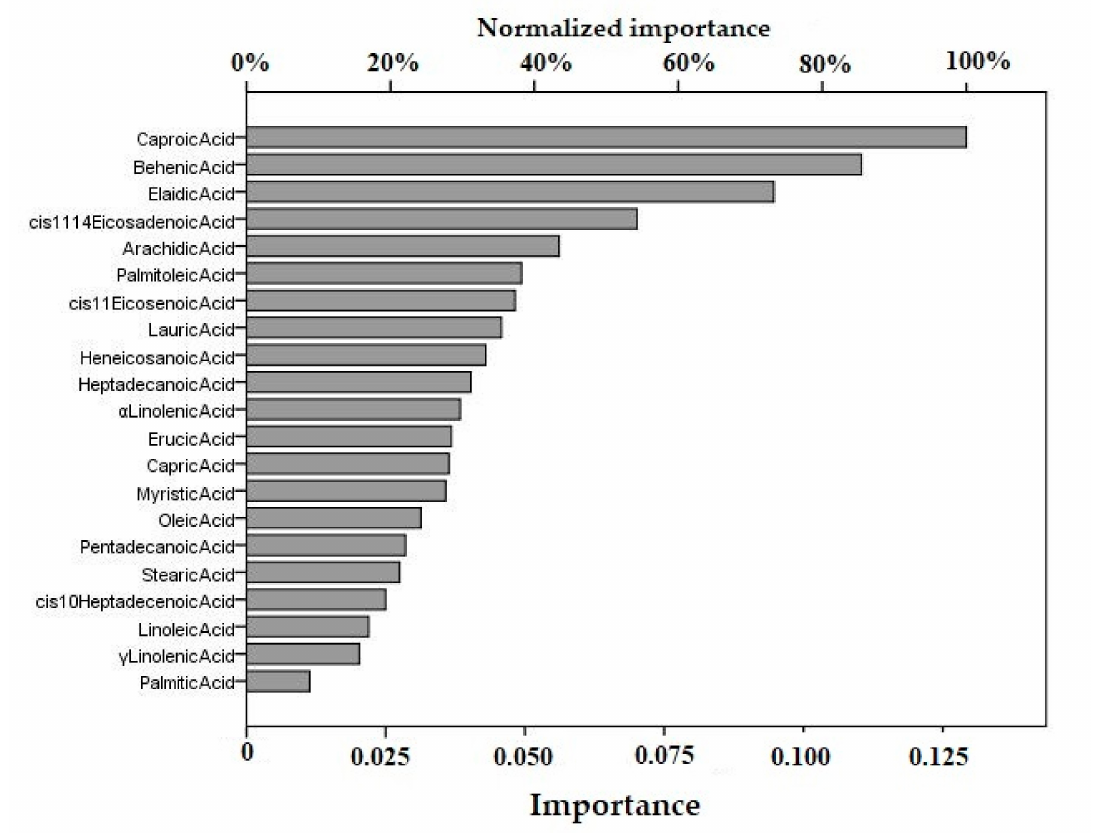
Figure 7. Independent variables importance chart obtained for oil sample